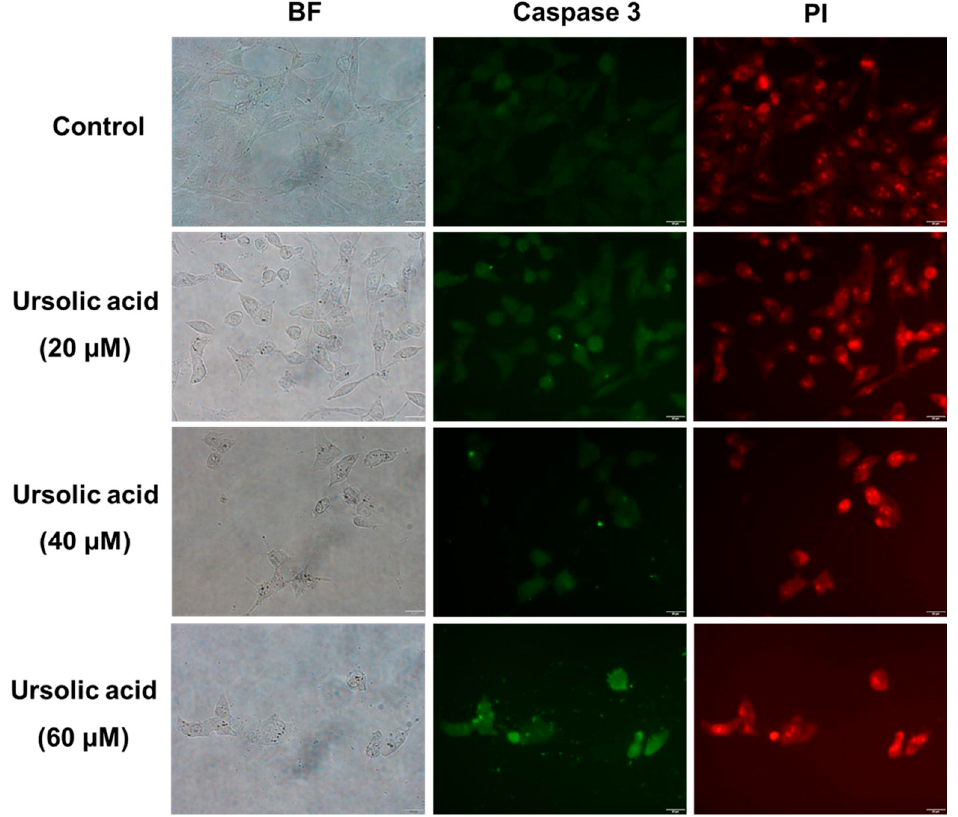
Figure 5. Immunocytochemical analysis. SK-Hep-1 cells were treated with 0, 20, 40, and 60 μ M UA for 24 h and then fixed with 4% paraformaldehyde to allow for detection by caspase 3 antibody. The results revealed that treatment with UA for 24 h resulted in increased expression of caspase-3.